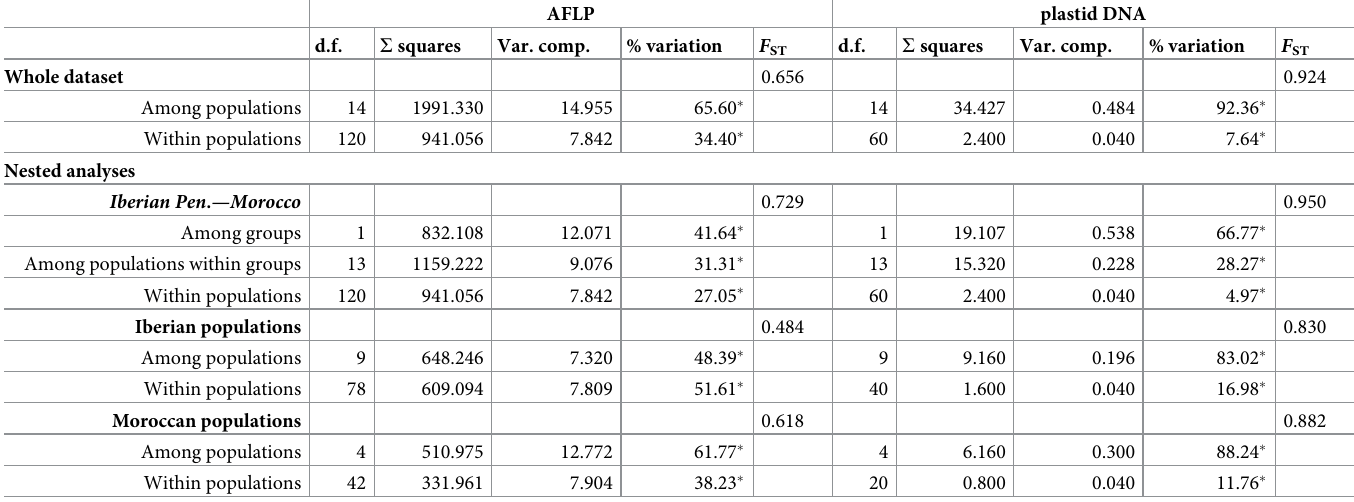
and 0.195, respectively) were higher than those of Iberian ones (43.6% and 0.163, respectively). Table 3. Results of analysis of molecular variance (AMOVA). AMOVA results for AFLP phenotypes and plastid DNA haplotypes from populations of Cynara baetica . ( � = p < 0.05 after 10,100 permutations). AFLP plastid DNA